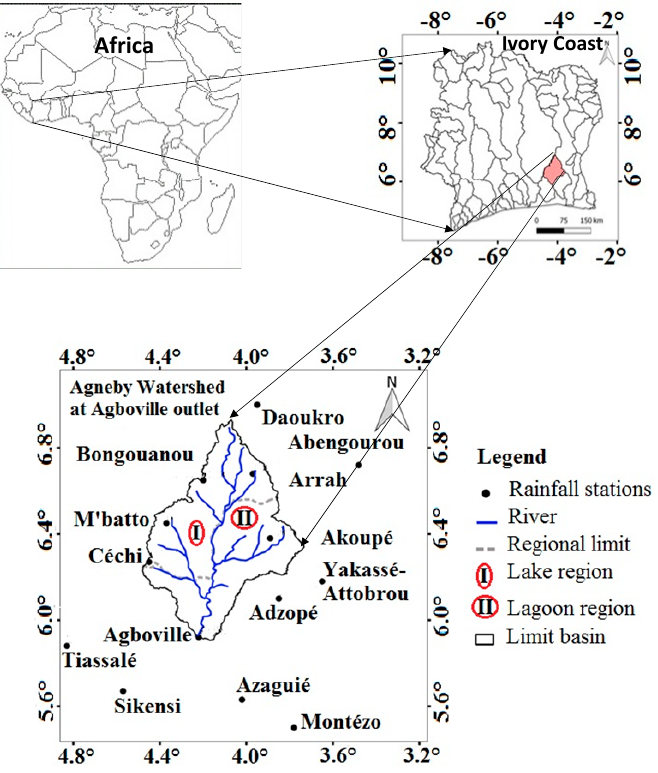
Figure 1. Location of the Agneby watershed at the Agboville outlet and the rainfall stations. Table 1. Characteristics of the rain gauges of the Agneby watershed in Agboville. Rainfall